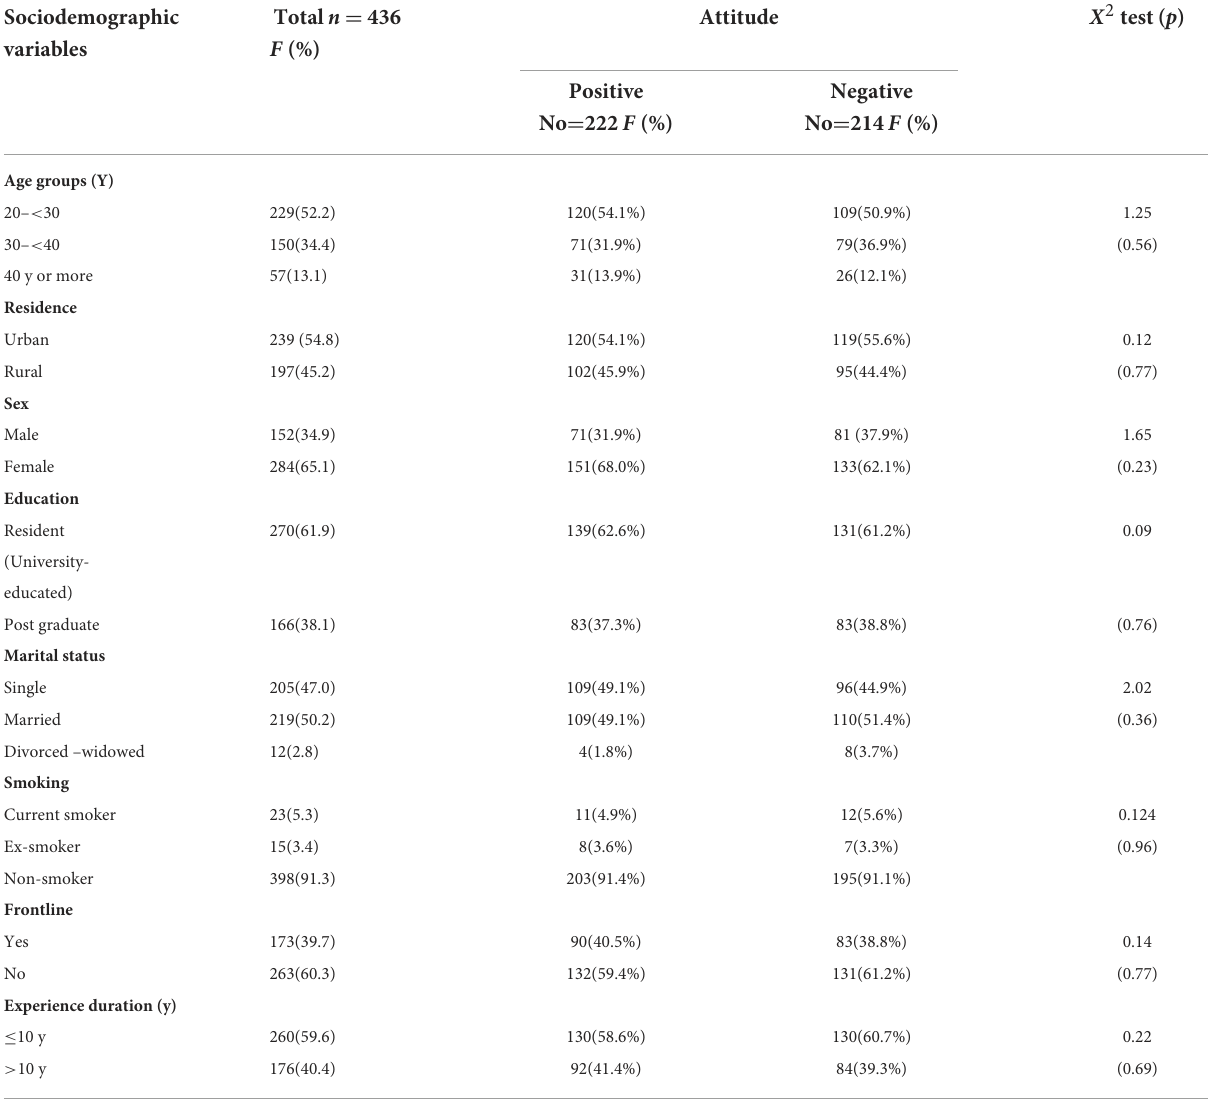
TABLE 1 Association between sociodemographic and attitude toward COVID-19 vaccine uptake.